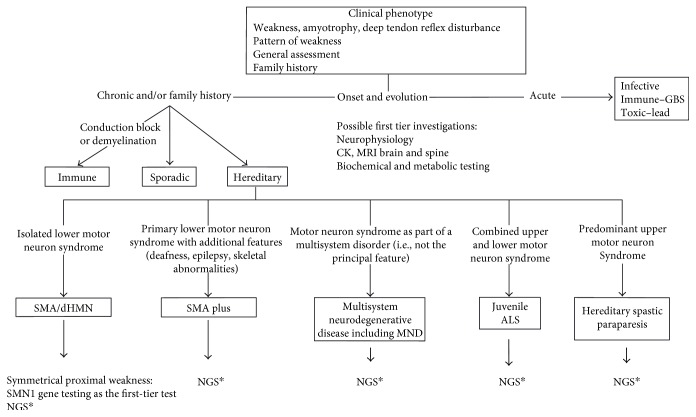
Diagnostic approach for a patient (<18 years) with a motor neuron disorder (MND). ALS: amyotrophic lateral sclerosis; CK: creatinine kinase; dHMN: distal hereditary motor neuropathy; GBS: Guillain-Barre syndrome; MND: motor neuron disorder; MRI: magnetic resonance imaging; NGS: next generation sequencing. ∗genomic testing by panel; WES or WGS may be an option depending on local availability.